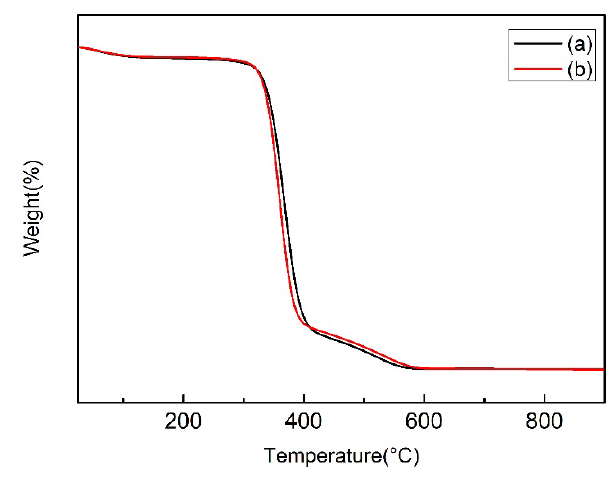
Figure 12. TG curves: ( a ) CF; ( b ) CF-TiO 2 .